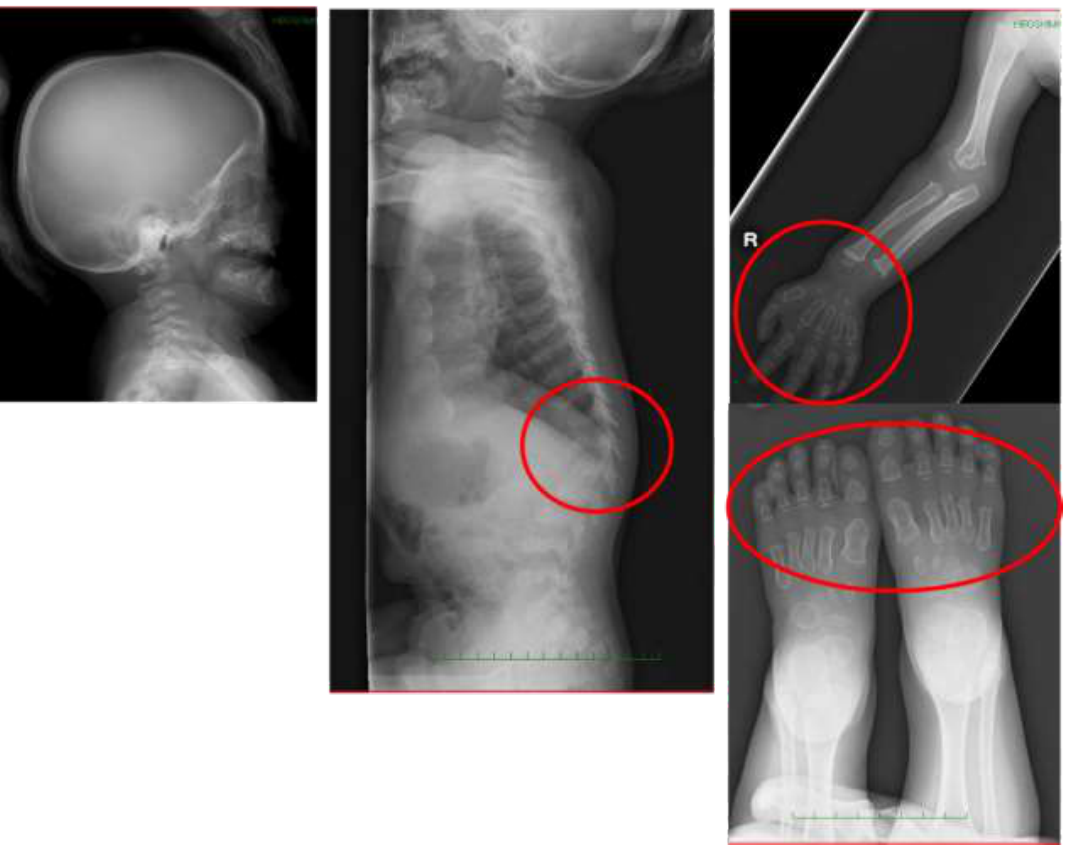
Figure 1. A whole-body X-ray from the first visit of a Japanese boy with MPS IVA. The findings of multiple dysostosis, such as the anterior tongue of the vertebrae and a dumbbell-like deformity in the proximal and middle phalanges of the hands and feet were observed.